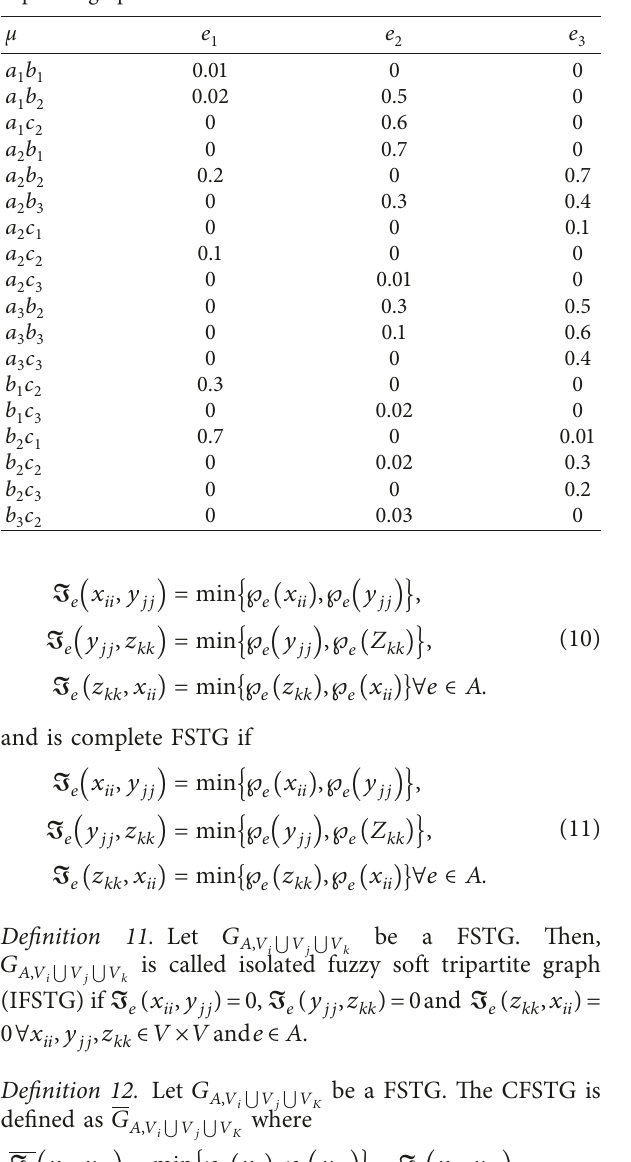
Table 2: Relation between vertices and edges of perfect fuzzy soft tripartite